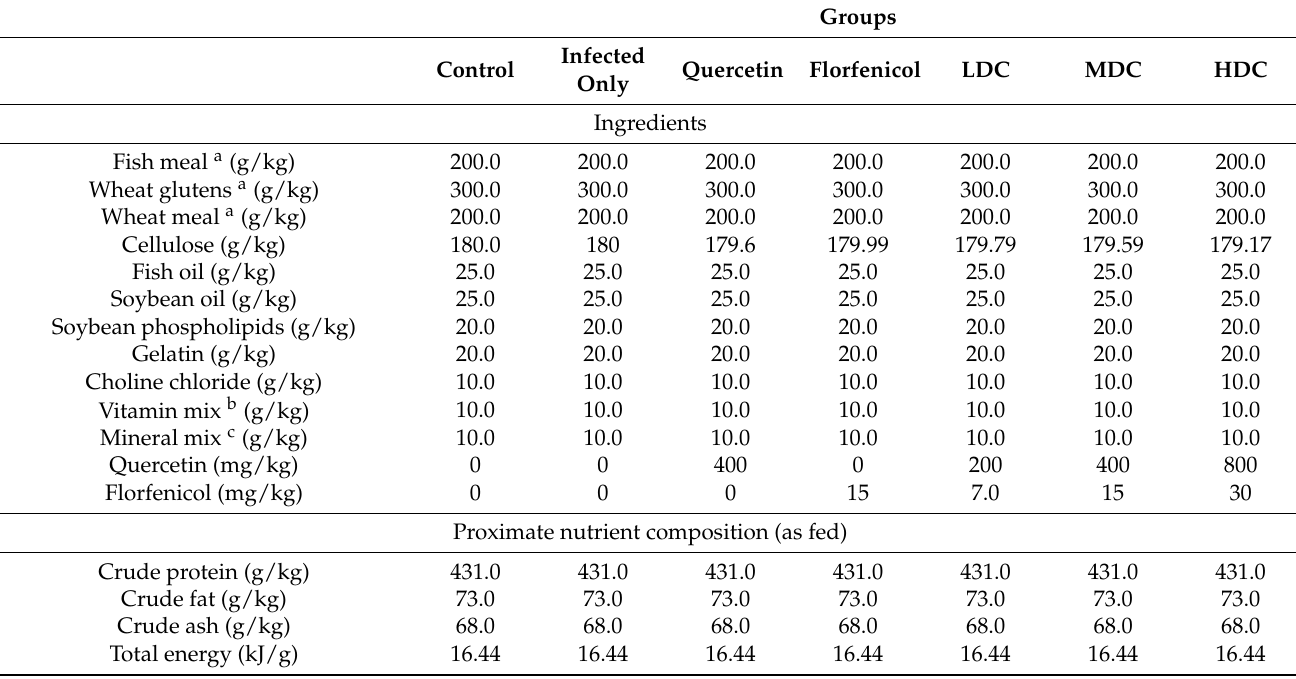
Table 1. The formula composition of the diets in the